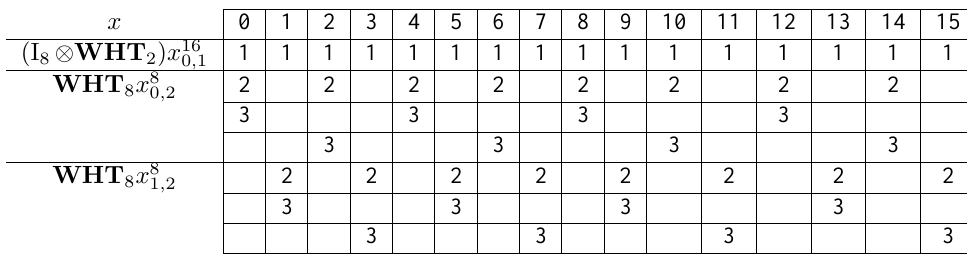
Tab. 1: Memory Access Pattern for Algorithm (a) in Figure 3